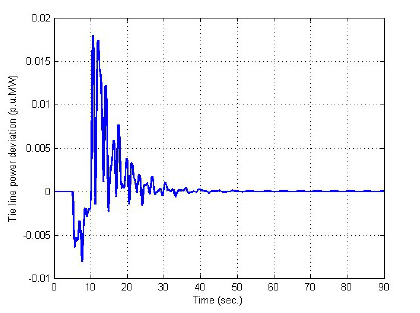
Fig. 14: Tie-line power deviation (Case 3)